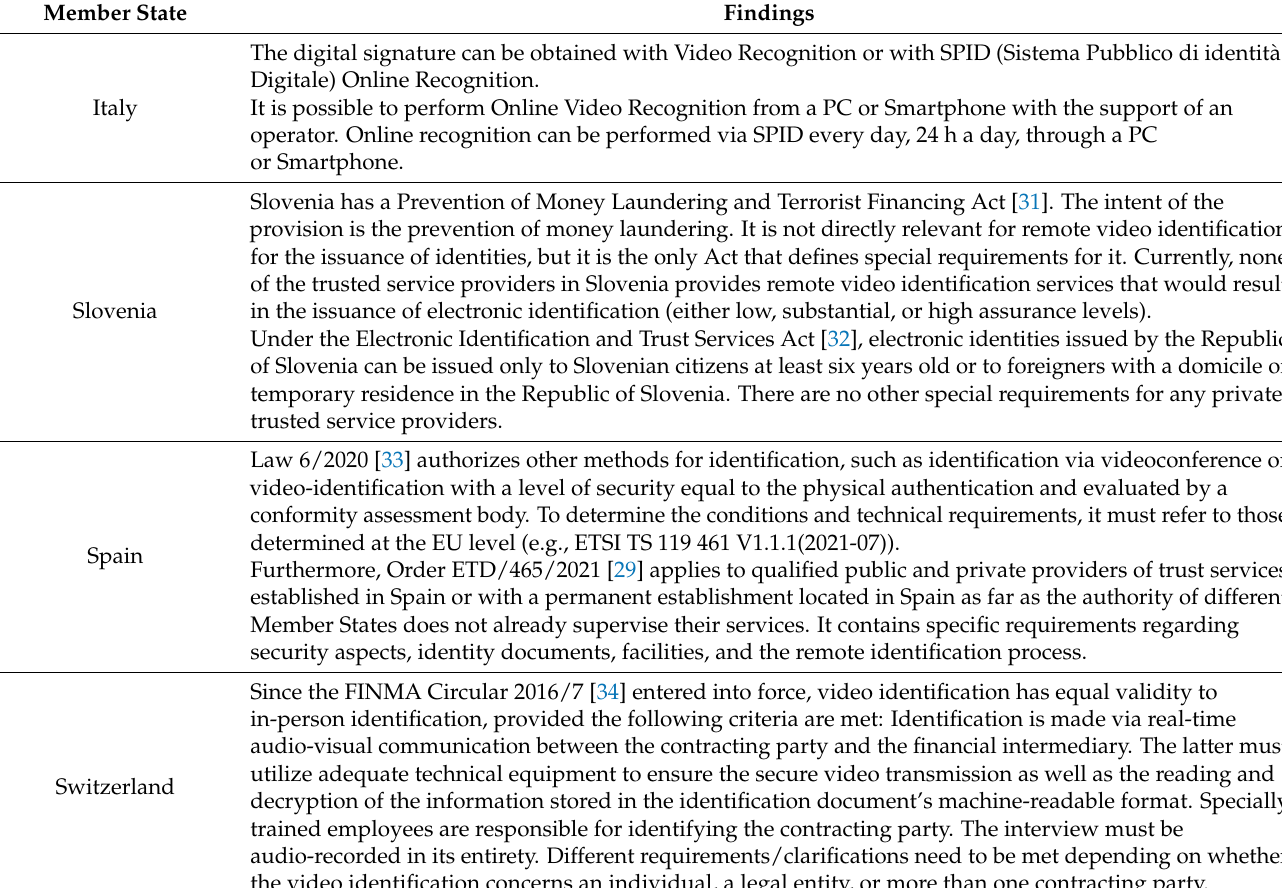
Table 3. Remote video identification for the sampled